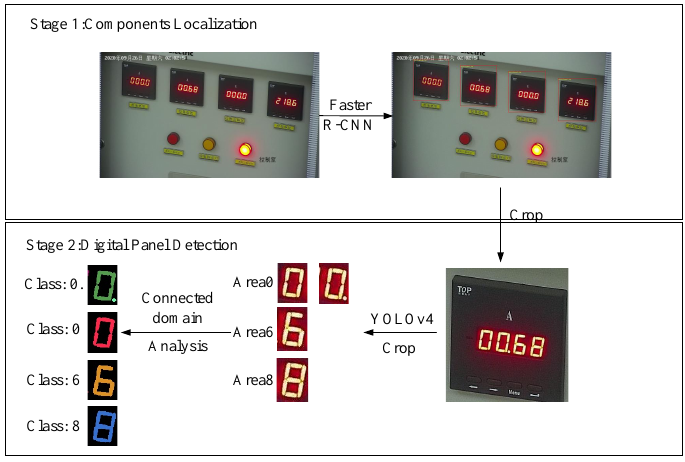
Figure 1. Overall framework of digital instrument readings